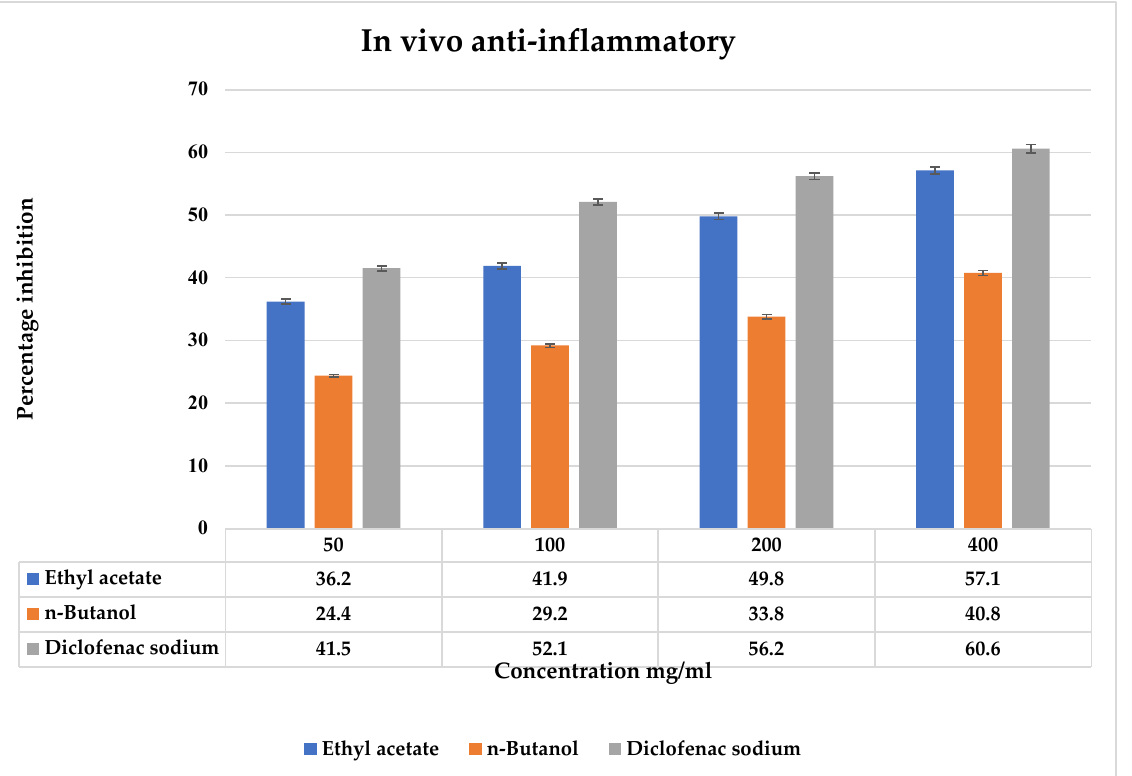
Figure 7. In vivo anti-inflammatory activity of the fractions of T. vulgaris . The vertical bar represents the mean ± S.E. The values were expressed in the mean ± SD of triplicates, and all values were statistically significant at p < 0.05.